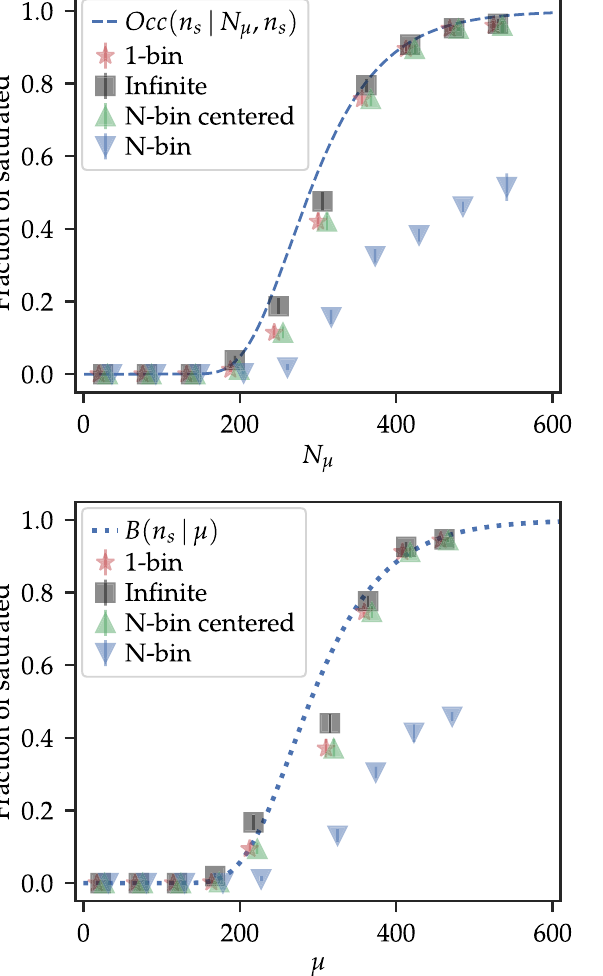
Fig. 16 Saturation fraction as a function of N μ (upper panel) and as a function of μ (lower panel), as modeled (dashed and dotted lines) and from simulations (markers), for the four considered strategies. The simulations consist of proton air-showers with 17 . 8 ≤ log 10 ( E / eV ) ≤ 18 . 0 and 18 ◦ (cid:2) θ (cid:2) 27 ◦ (0 . 10 ≤ sin 2 θ ≤ 0 . 20), with a uniform